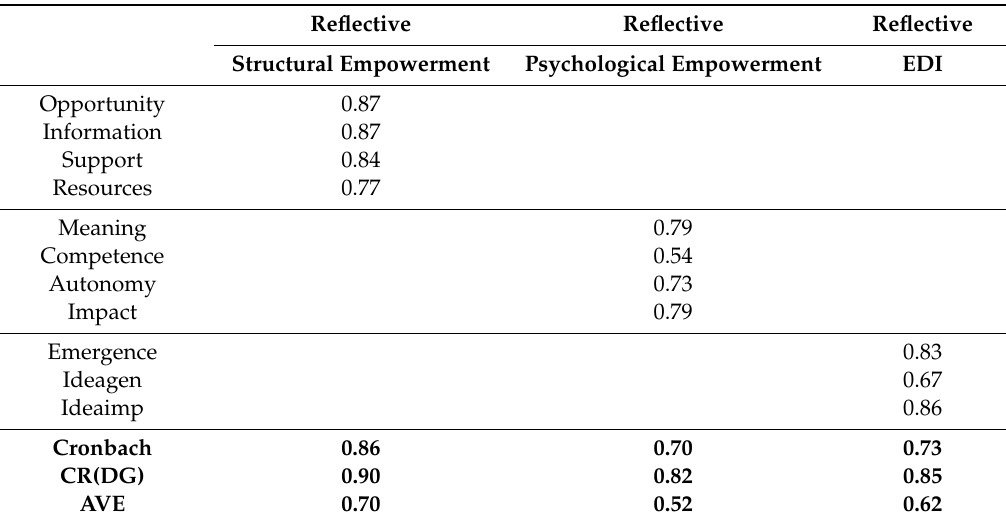
Table 4. Model—standardized factor loadings.